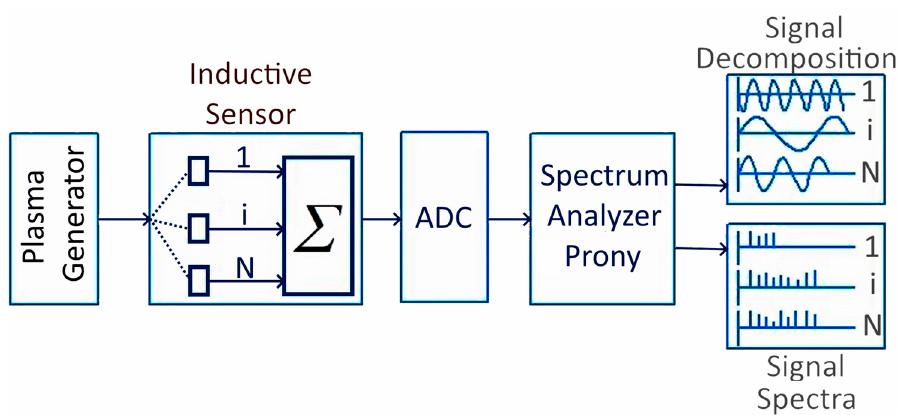
Figure 3. Structural diagram of the broadband Prony spectrum analyzer of electromagnetic radiation from glow discharge plasma.